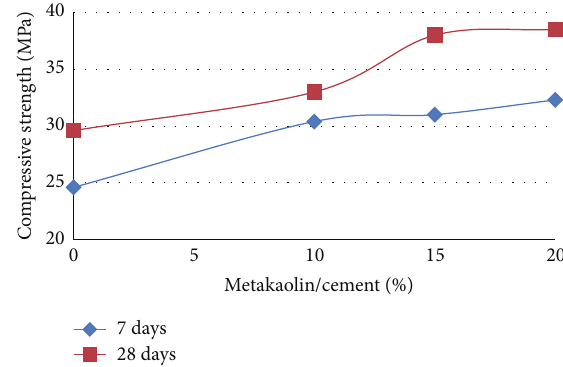
Figure 5: Effect of polymer and MK on workability for modified concrete with w/c 45%.